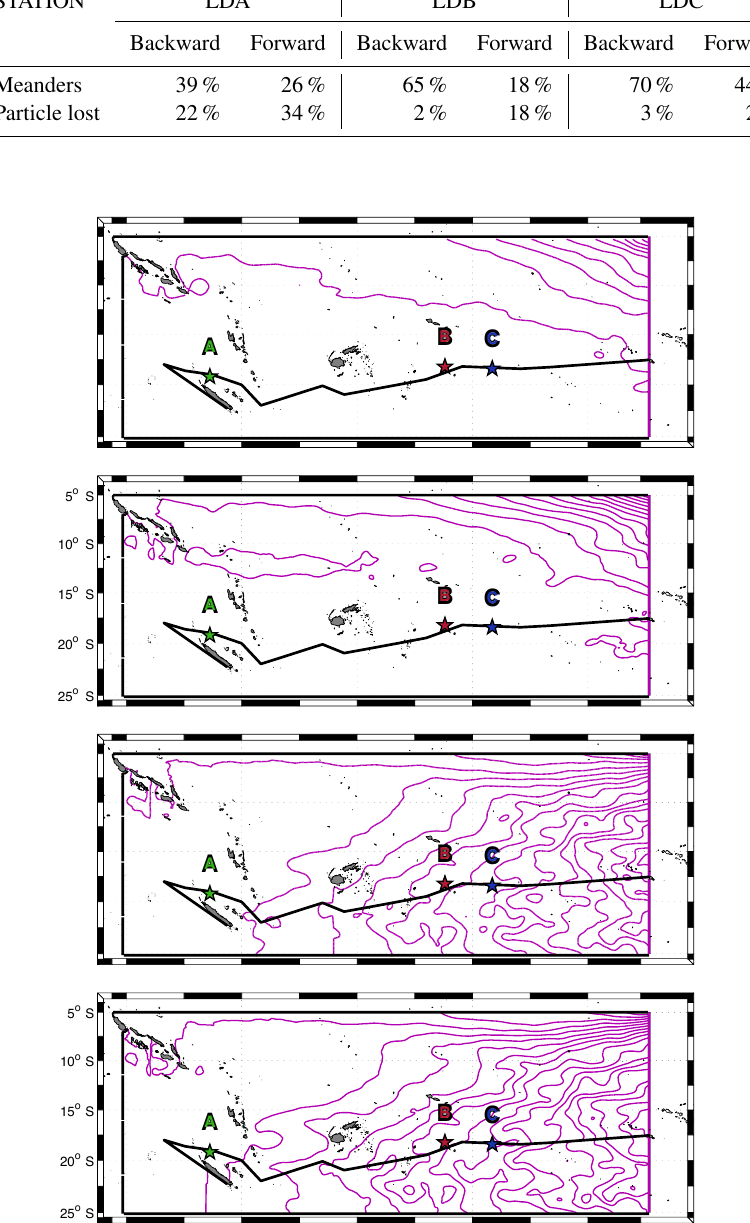
Figure A1. Forward stream functions computed for a 10-year period with, from top to bottom, the low-resolution geostrophic product of AVISO; the high-resolution geostrophic product from CLS; the high-resolution geostrophic and Ekman (at 15m) product from CLS; and the high-resolution geostrophic, Ekman (at 15m) and cyclogeostrophic product from CLS (referred to as the total altimetry-derived product in the text). The initial section of Ariane Lagrangian analysis is indicated with a purple vertical line to the east. The ship track and locations of OUTPACE LD stations are indicated with the black line and coloured stars as referred to in Fig.